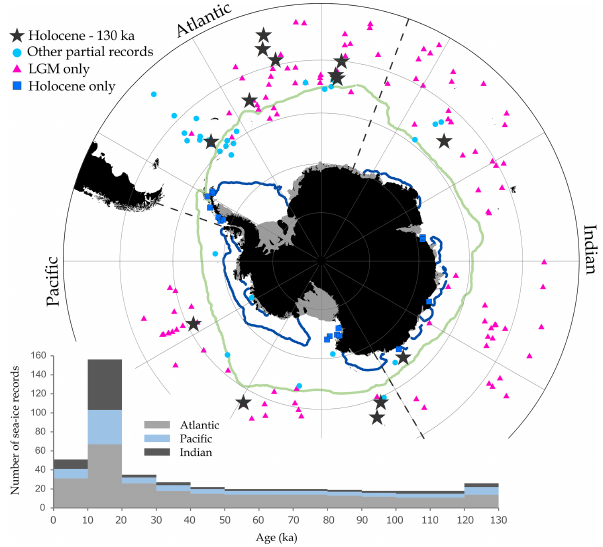
Figure 3. Compilation of marine sea-ice proxy records. Map: loca- tions of sediment cores with published sea-ice records. The 1981– 2010 monthly median sea-ice extent is shown for February (blue line) and September (green line) (Fetterer et al., 2017). Plot: cumu- lative number of published sea-ice records vs. time from the At- lantic (light grey), Indian (dark grey) and Pacific (light blue) sec- tors of the Southern Ocean. (Figure adapted from Chadwick et al., 2019). The list of the cores presented herein can be found in Ta- ble S2. LGM: Last Glacial